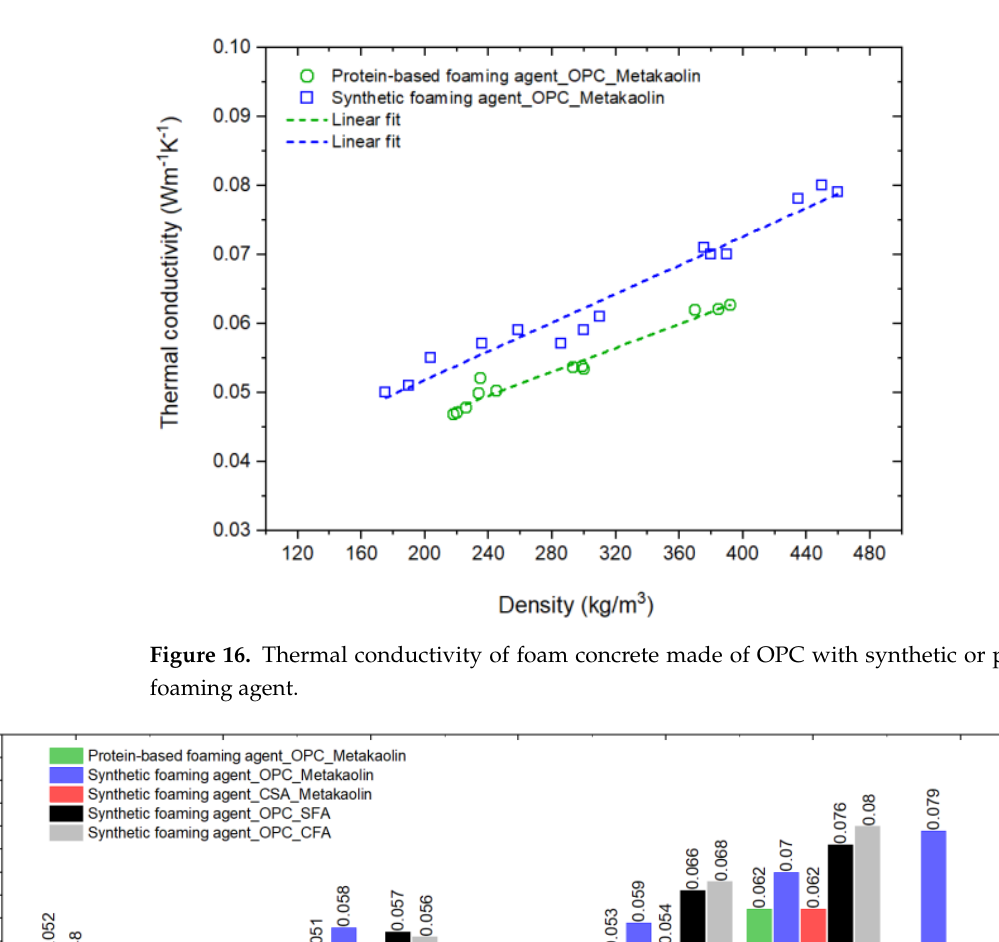
Figure 17. Average thermal conductivity for all tested foam concrete.